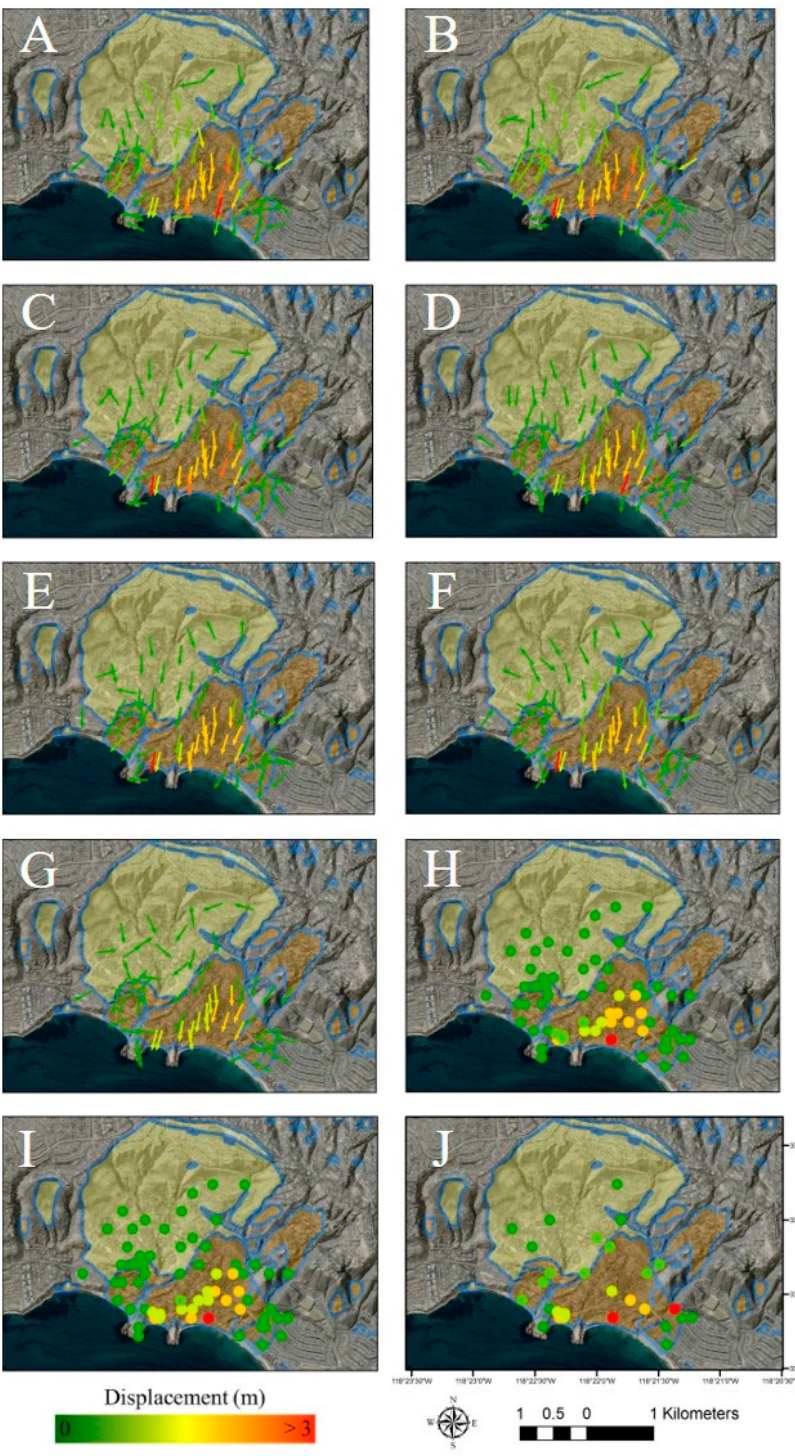
Figure 2. Incremental displacement (m) measured through annual GPS surveys from [28]: ( A ) 24 September 2007–10 December 2008; ( B ) 10 December 2008–18 November 2009; ( C ) 18 November 2009–25 October 2010; ( D ) 25 October 2010–3 October 2011; ( E ) 3 October 2011–14 September 2012; (F) 14 September 2012–4 October 2013; ( G ) 4 October 2013–19 September 2014; ( H ) 19 September 2014–8 October 2015; ( I ) 8 October 2015–5 October 2016; ( J ) 5 October 2016–3 May 2017. Displacement magnitude shown using color scale (green to red). Displacement direction shown using arrows (displacement direction unavailable for H , I , and J